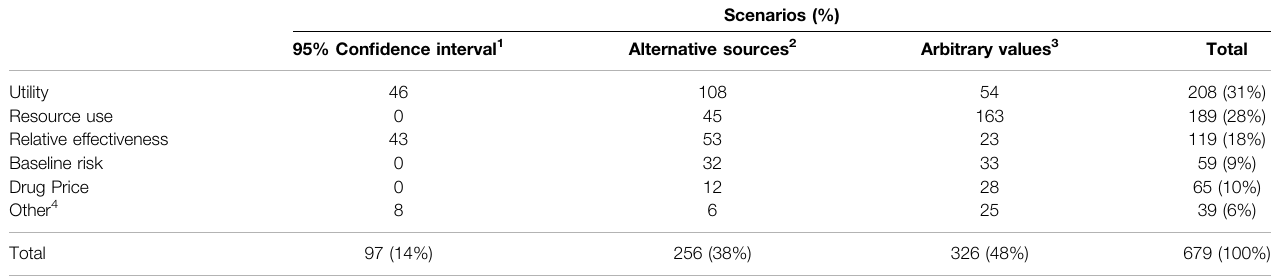
TABLE 3 | The ranges of values used in the parametric sensitivity analysis of the 50 dossiers submitted to the Economic Sub-Committee for listing at the Korean National Health Insurance.